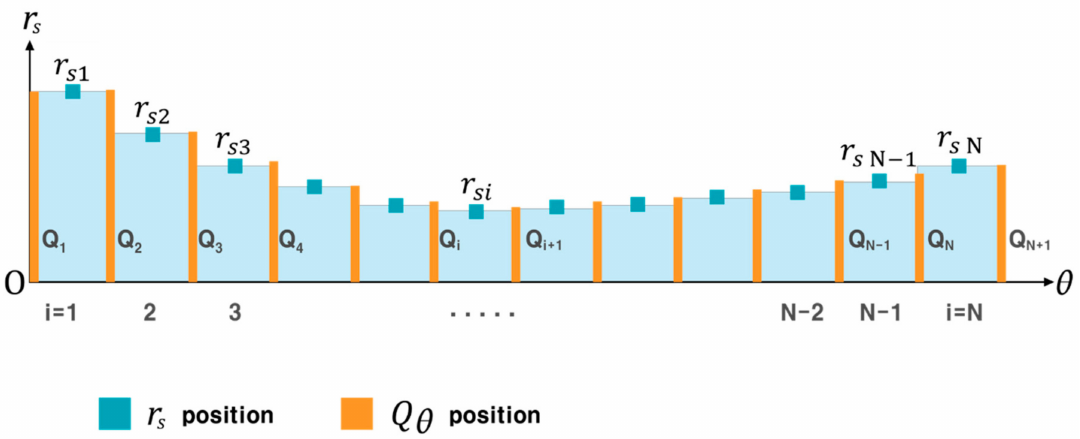
Figure 5. Numerical analysis of shoreline change